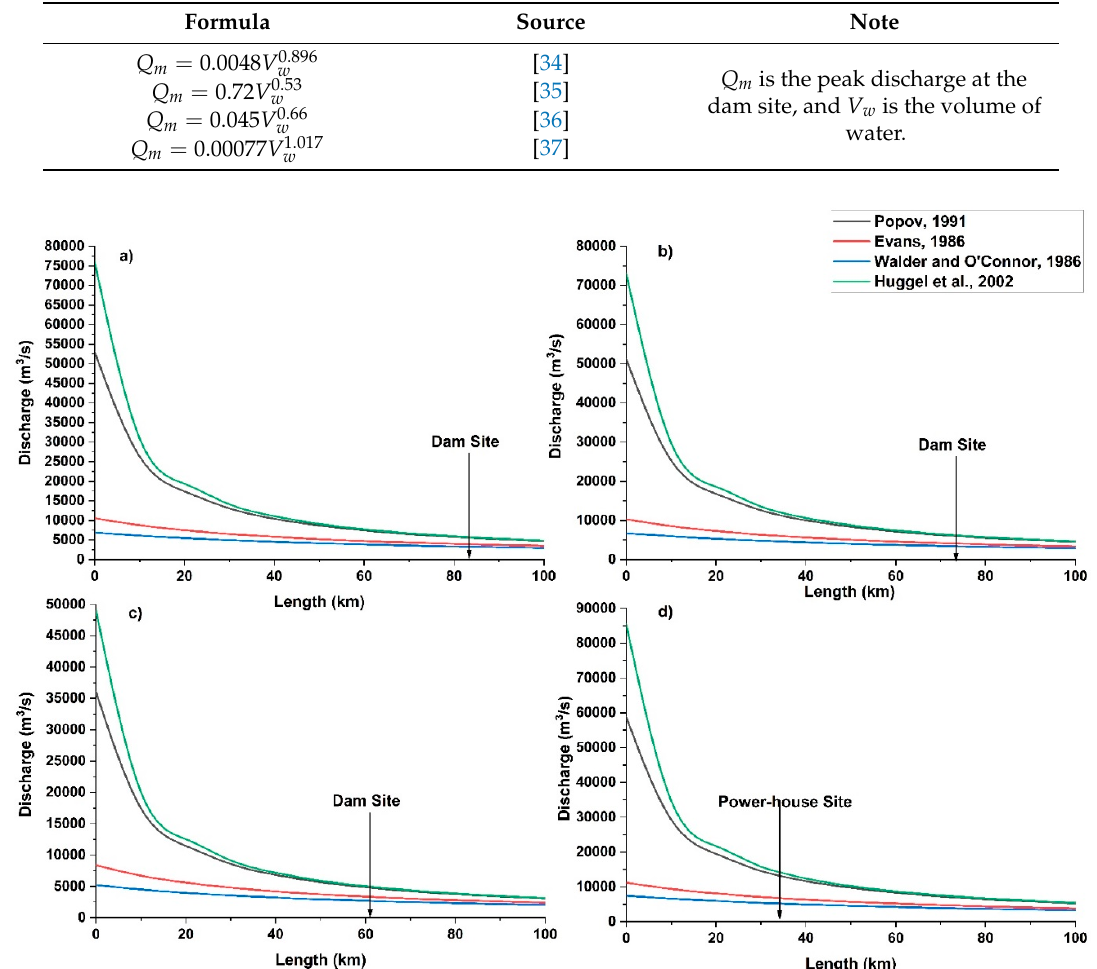
Table 3. Empirical formulas for calculating the peak discharge at the glacial lake dam site.